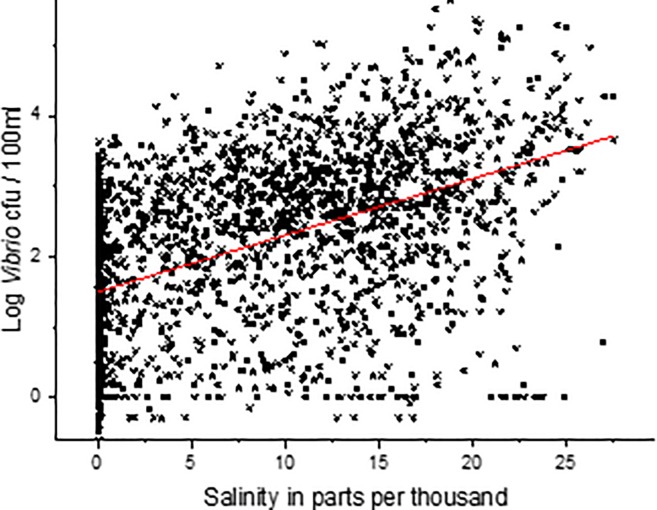
Linear regression of salinity and log Vibrio concentration at all stations and depths (N = 2120).Regression line = p<0.05 r2 = 0.23.